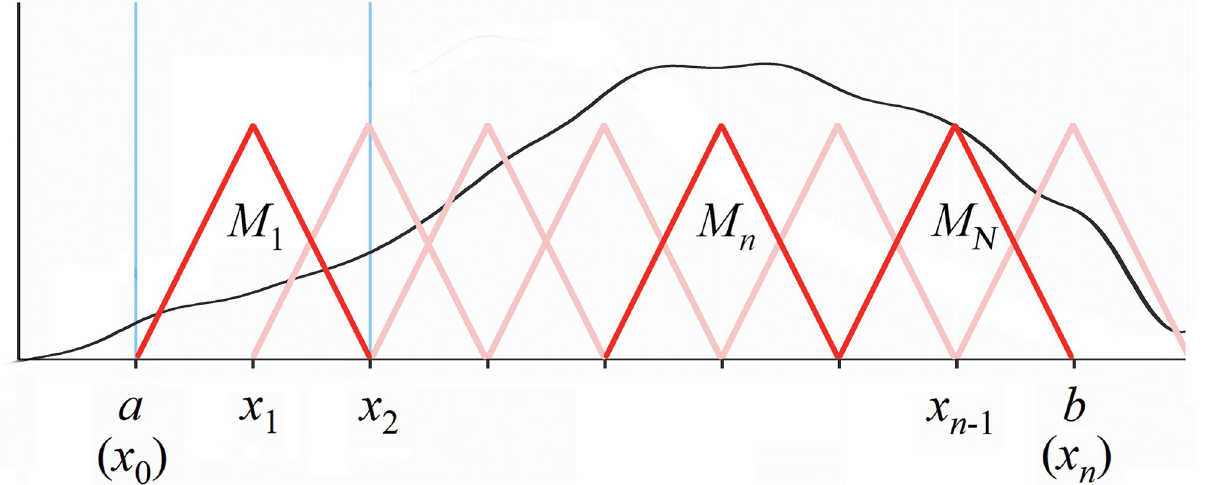
Fig 3. The triangular function for fuzzy